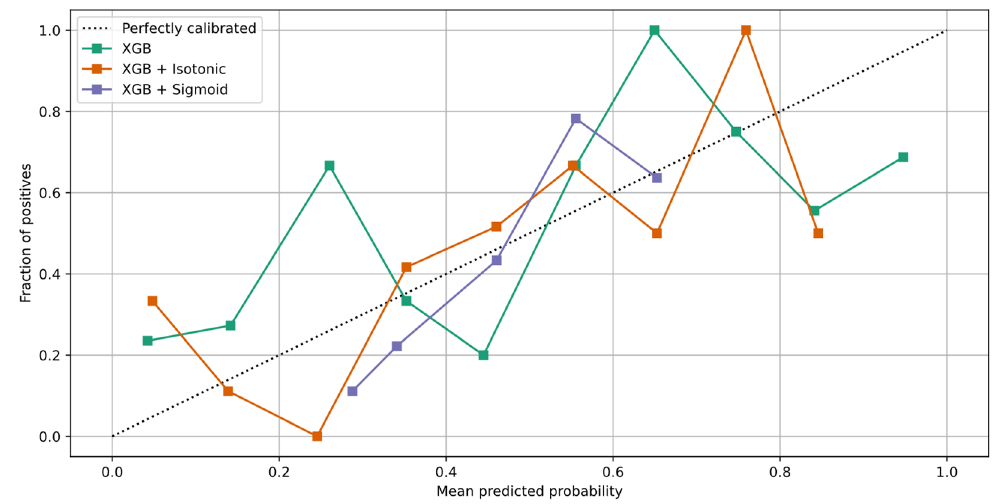
Figure 11. Calibration plot of XG Boost classifier for class 2.